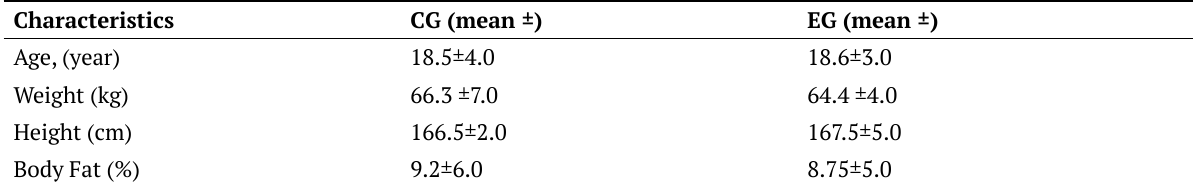
Table 1. Anthropometric characteristics (n=20) Characteristics